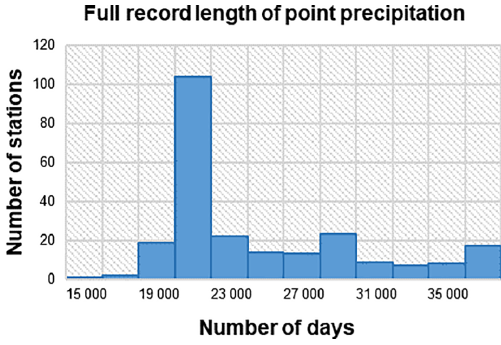
Figure 2. Distribution of full record length of point precipitation based on weather